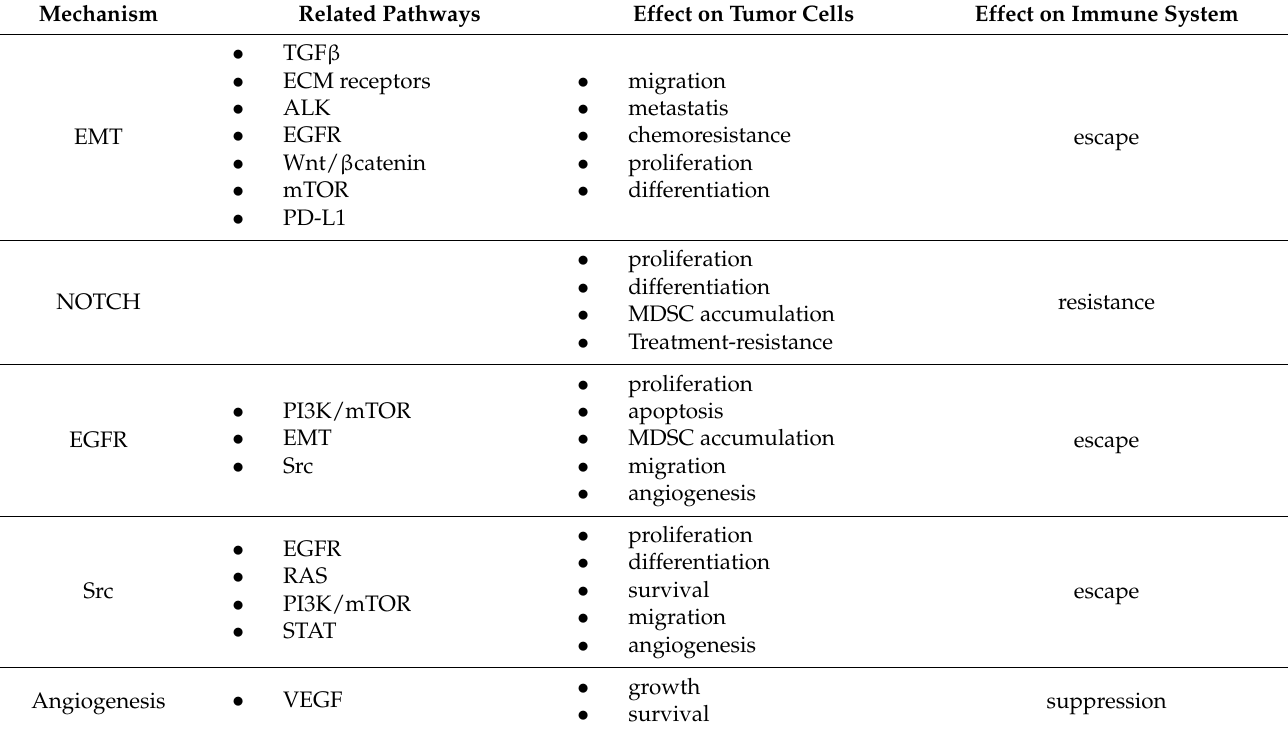
Table 2. Effects of pathways dysregulation in mesenchymal breast cancer triple negative subtype. Mechanism Related Pathways Effect on Tumor Cells